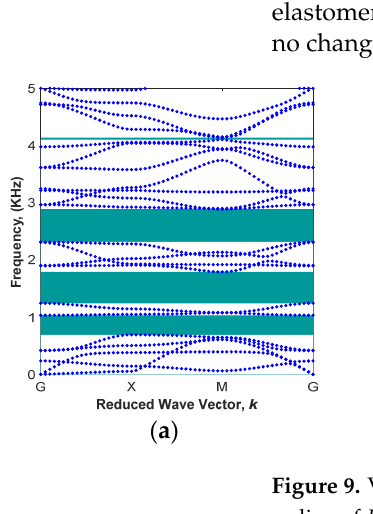
( b ) Figure 8. Evolution of bandgap areas in different arm angles ( (cid:3398) 2.5 (cid:3407) 𝜃 (cid:3407) 10 ) in the fixed cylindrical core radius of 𝐿 𝑅 ⁄ (cid:3404) 5 and iron volume fraction of 13.94%: ( a ) bandgap area; ( b ) percent of bandgap area in the range of 0 and 5 kHz . 3.1.3. Effect of Iron Volume Fractions on Passive MRE Unit Cell In this section, the proposed MRE ‐ based modified periodic structure with a cylindri ‐ cal core radius of 𝐿 𝑅 ⁄ (cid:3404) 5, and the arm angle of 𝜃 (cid:3404) 0 is considered to evaluate the effect